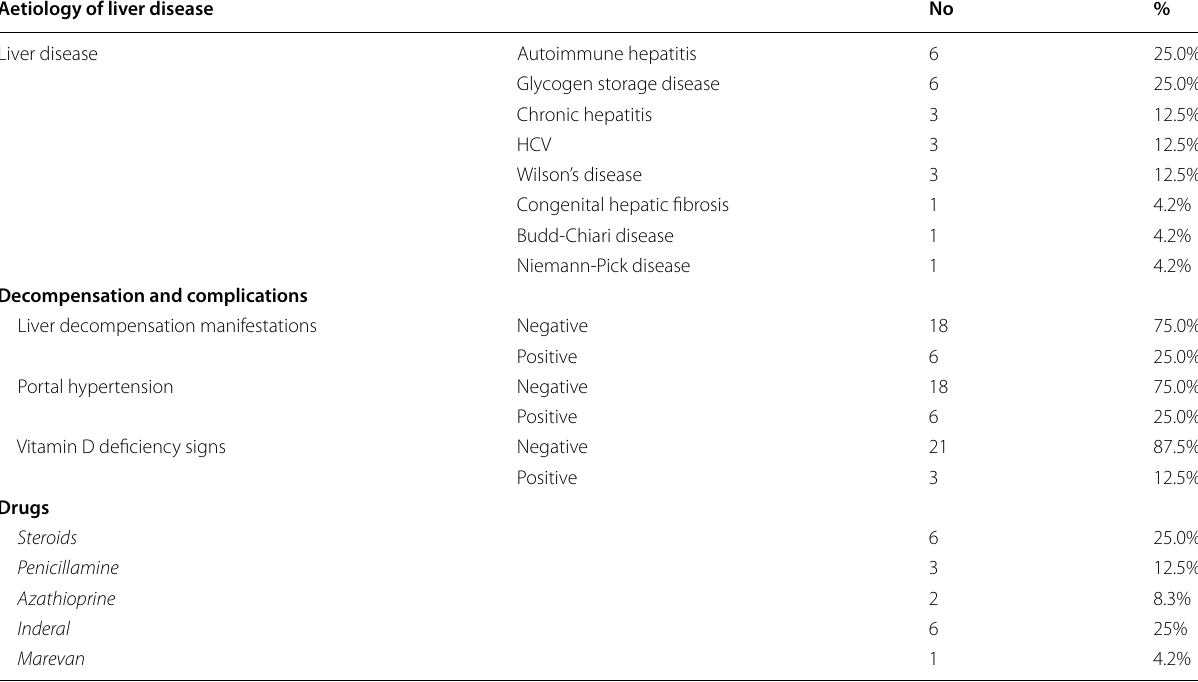
Table 2 Liver disease aetiology, decompensation, complications and drug history of the participants Aetiology of liver disease Liver